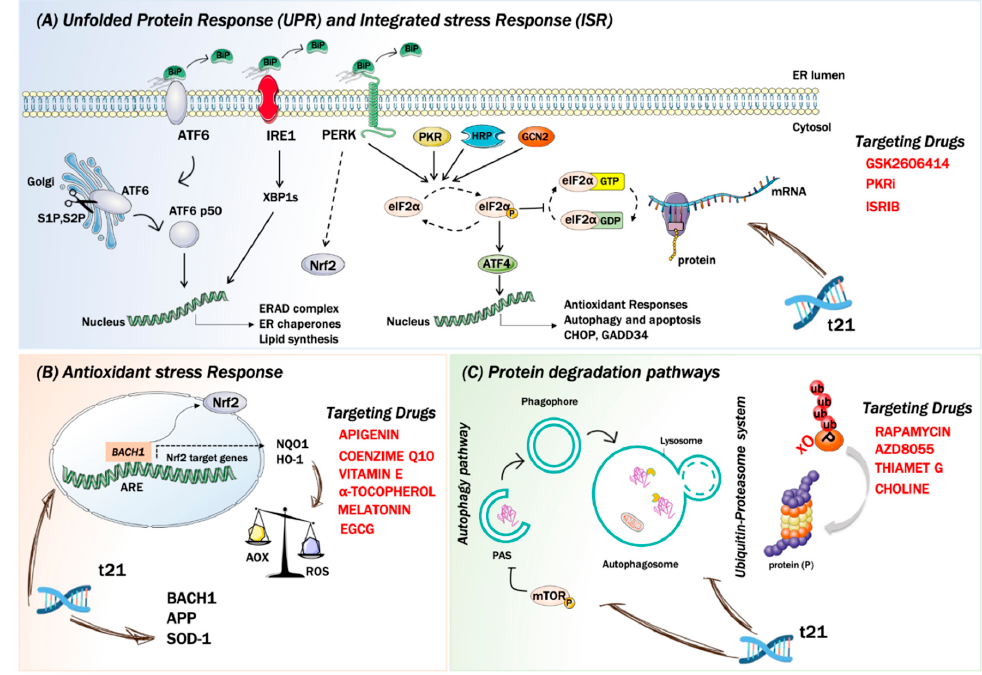
Figure 1. Stress responses in down syndrome neuropathology and therapeutic approaches. Panel ( A ) The unfolded stress response (UPR) and the integrated stress response (ISR) are dysregulated in Down syndrome (DS) and contribute to neu- rodegenerative processes. Under homeostatic conditions, IRE1, PERK, and ATF6 (UPR sensors) are anchored to the ER membrane by association with BiP. Upon activation of the UPR, BiP releases the effectors of the three branches of the UPR. (A) In the pro-survival, adaptive response, IRE1 dimerizes and autophosphorylates. Phosphorylated IRE1 activates XBP1, which in turn is translocated into the nucleus to upregulate the transcription of other adaptive UPR genes. Chronic acti- vation of the UPR leads to pro-apoptotic signals. IRE1 induces apoptosis by activating ASK1 and consequently JNK. ATF6, translocate into the nucleus to enhance transcription of UPR genes. PERK is the only kinase of the UPR that overlap with ISR sensor kinases. PERK dimerizes, autophosphorylates, and targets Nrf2 and eIF2 α . PKR, GCN2, and HRI (ISR sensors) once activated converge on the eIF2a phosphorylation, to elicit a translational and transcriptional stress response. Thus, inhibiting the initiation of translation, shutting down protein synthesis, and therefore reducing the load of proteins at the ER. Phosphorylation of eIF2 α also triggers the translation of specific mRNAs, including key transcription factors, such as ATF4. In red are reported three targeting drugs used in Down syndrome (DS) acting at three different levels: GSK2606414 on PERK, ISRIB on eIF2a and PKRi on PKR. Panel ( B ) Increased OS is an early pathological characteristic of DS brain and is involved in the onset and progression of AD. In DS a number of genes, directly or indirectly, promote free radical production and alter redox homeostasis. Among these, SOD1, APP, and BACH1 has been recognized as ROS inducers. In DS Bach1 competes, in the nucleus, with Nrf2 for the binding to the antioxidant response elements (ARE) resulting in the increase of OS. In red are reported different antioxidant compounds used in DS both in pre-clinical and clinical study: Apigenin, Coenzyme Q10, Vitamin E, α tocopherol, Melatonin and EGCG. Panel ( C ) The UPS and autophagy are two main pathways involved in protein degradation and are emerged as a prominent disrupted mechanism involved in DS neuropathology. On the left a schematic representation of the autophagosome nucleation/maturation process is shown. Under pathological conditions, the hyperactivation of mTOR mediated by the phosphorylation on Ser2448 is responsible for autophagy inhibition. On the right a schematic representation of the ubiquitin proteasome system is shown. Most of the proteins targeted for proteasomal degradation are covalently modified with ubiquitin. In red are reported three com- pounds used in DS to rescue autophagy: Rapamycin, Choline and AZD8055. Furthermore, autophagy-deficient fibroblast demonstrated the accumulation of dam- aged mitochondria with a consequent increase in oxidative stress. This finding was asso- ciated with the reduced activation of the mitophagy pathway as regard as dysregulated PINK1/PARKIN signal [60]. Studies on the human brain from DS cases also proposed that increased ROS can target autophagy and exacerbate the inhibition of degradation path-